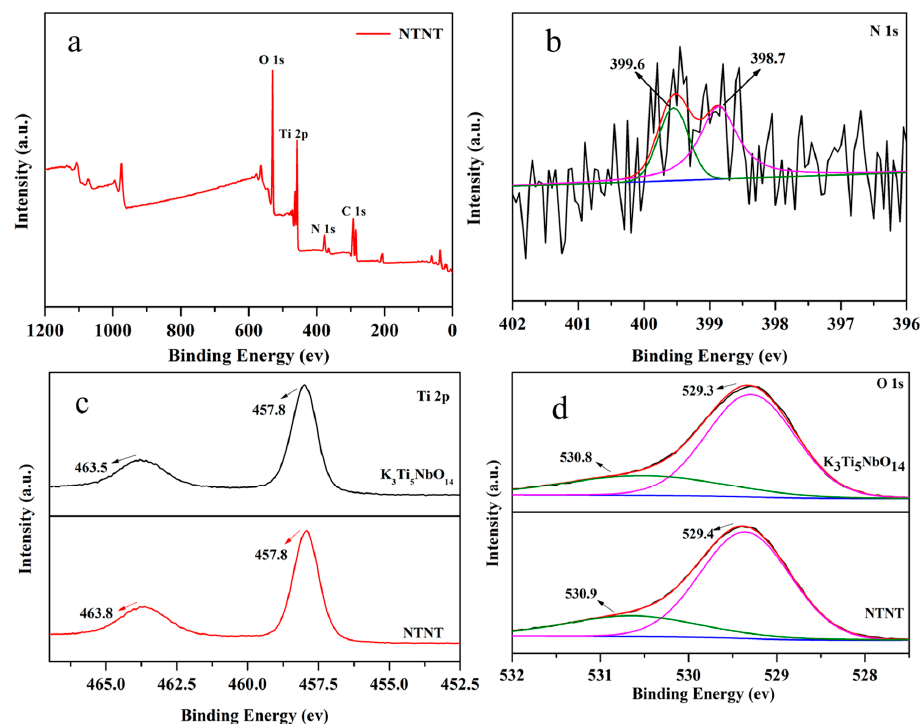
Figure 4. XPS spectra of NTNT: ( a ) Total spectra. ( b ) N1s spectra. ( c ) Ti 2p spectra. ( d ) O 1s spectra.